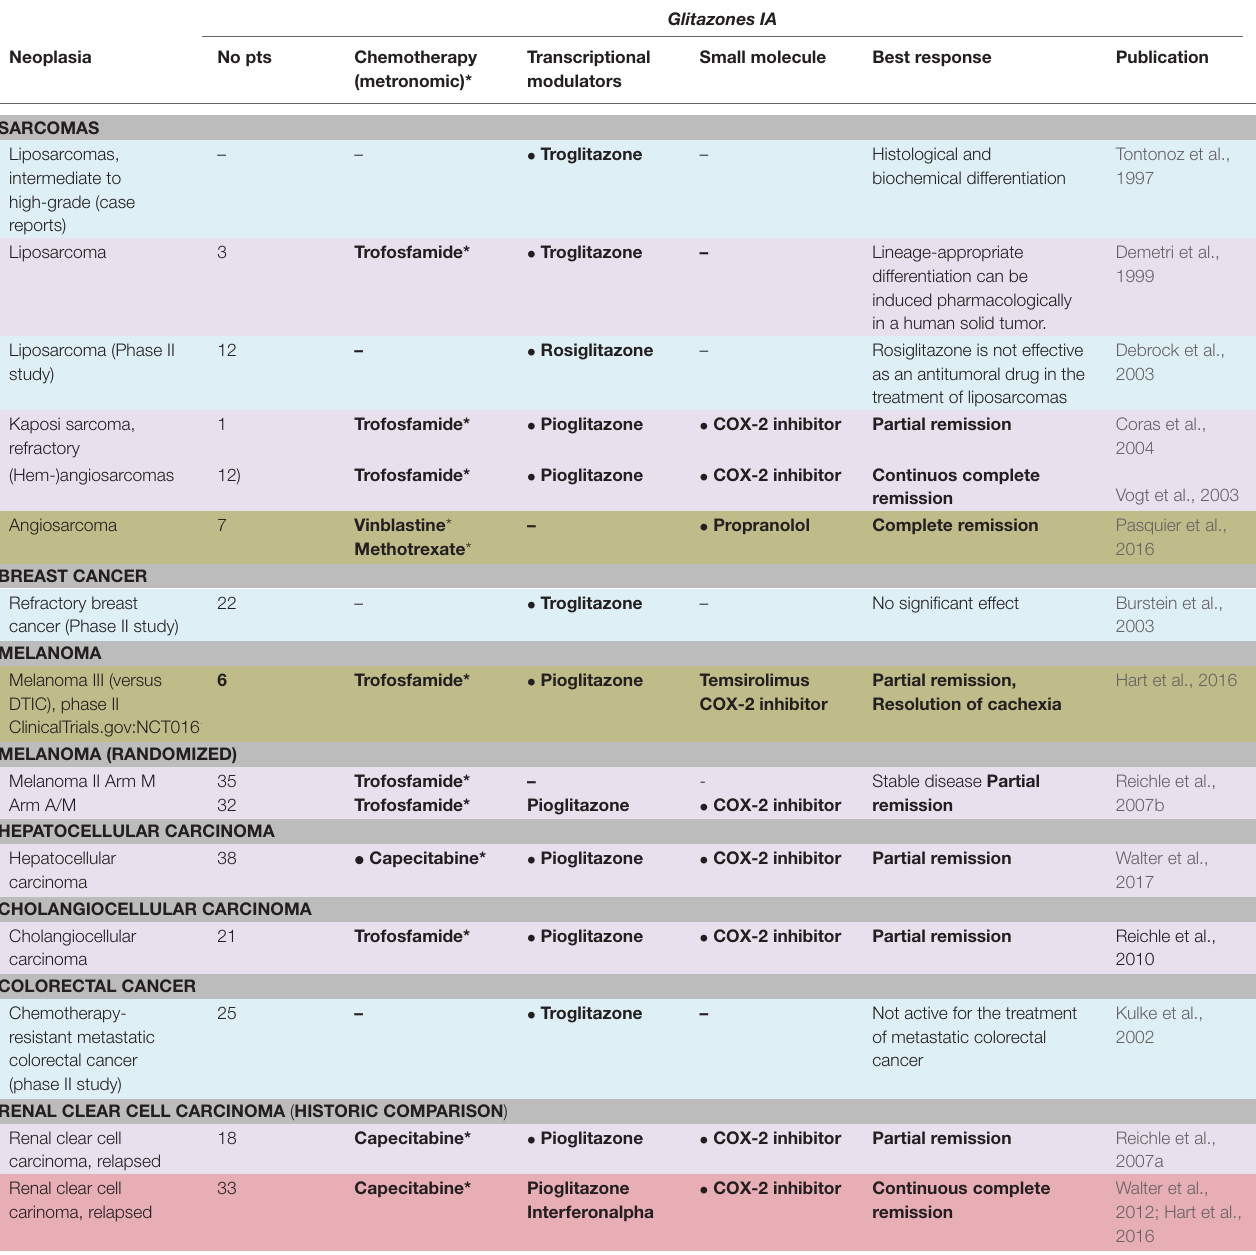
TABLE IA | Communicative reprogramming of tumor